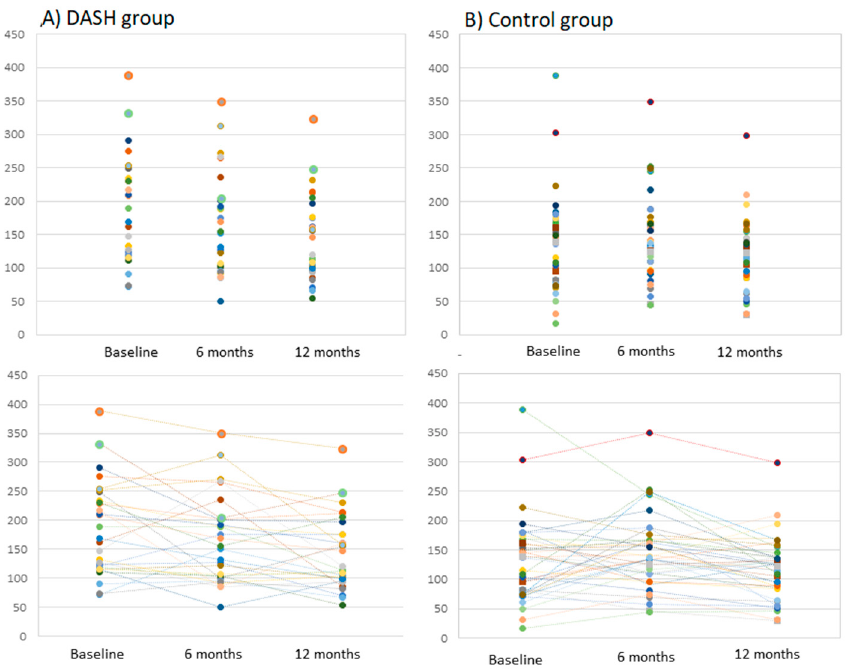
Figure 1. Individual MCP-1 plasma concentrations (pg/mL) and their changes during the study in the DASH group ( A ) and in the control group ( B ).